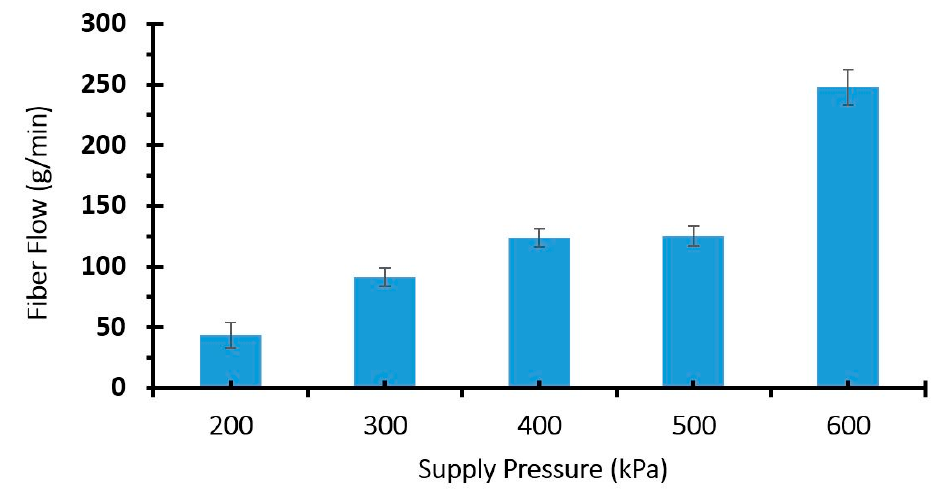
Figure 5. Correlation between supply air pressure and cumulative mass of fibers at the outlet of in-line vacuum.